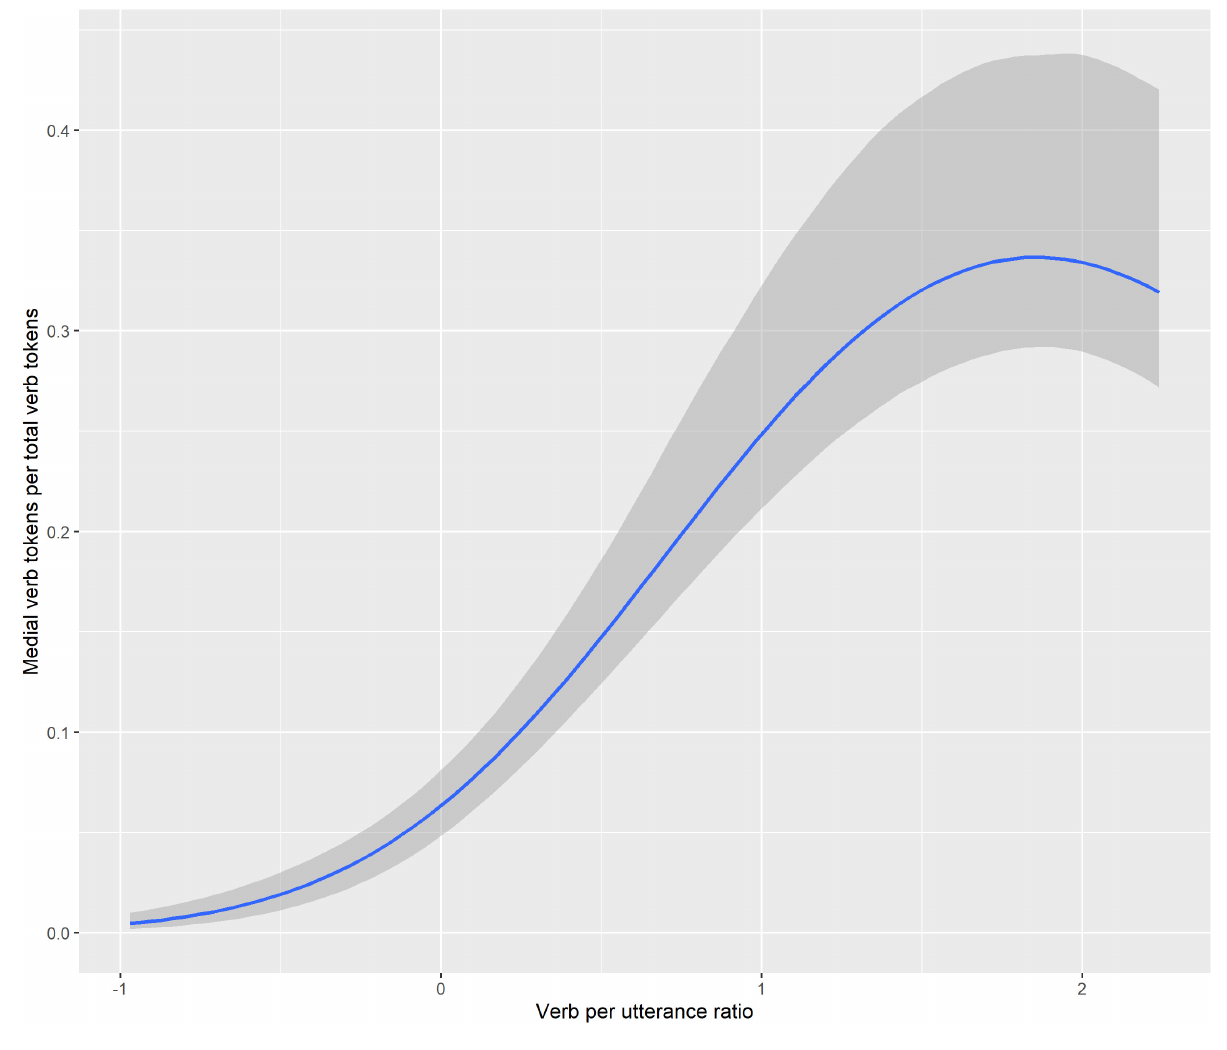
FIGURE 9 | Conditional effects of verb/utterance ratio on medial verb/verb